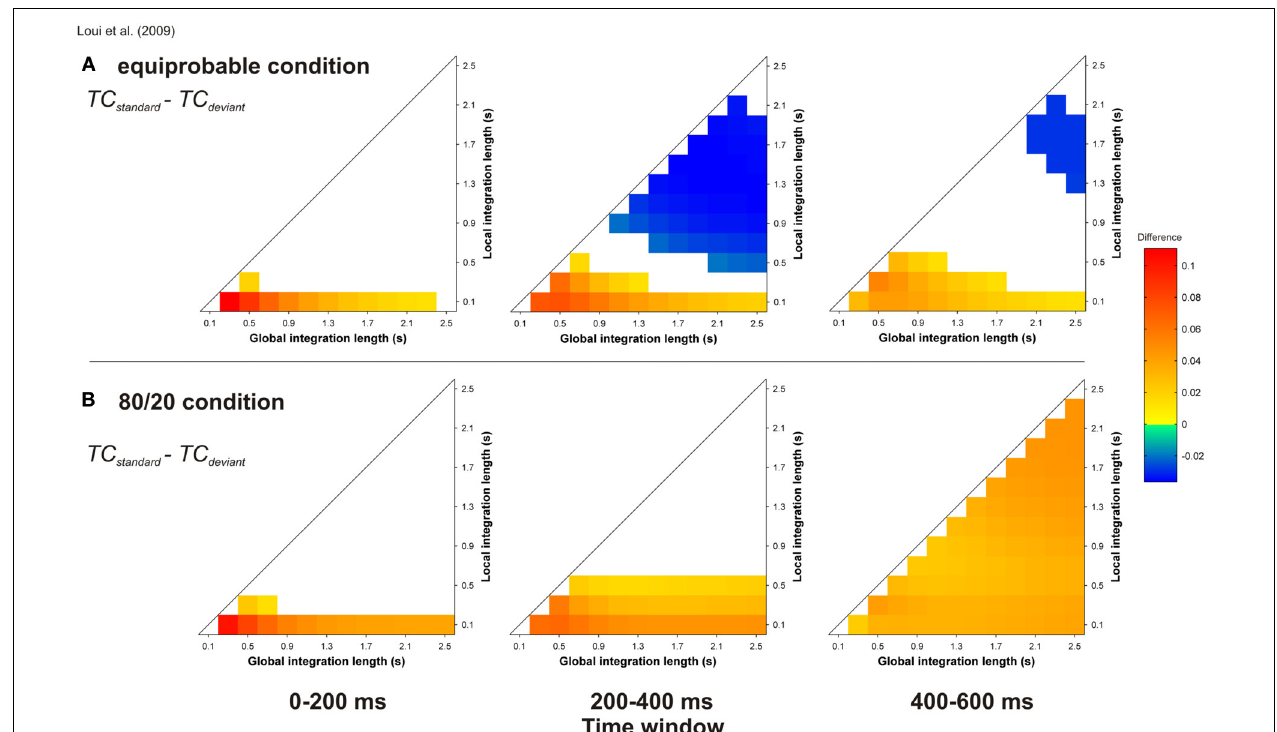
FIGURE 12 | Simulation of Loui et al.’s (2009) study. Mean TC differences between standard and deviant target chords for the equiprobable condition (A) and for the 80/20 condition (B) , as a function of the local and global context integration windows. Positive, negative, and nonsignificant differences are represented by hot, cold, and white colors, respectively